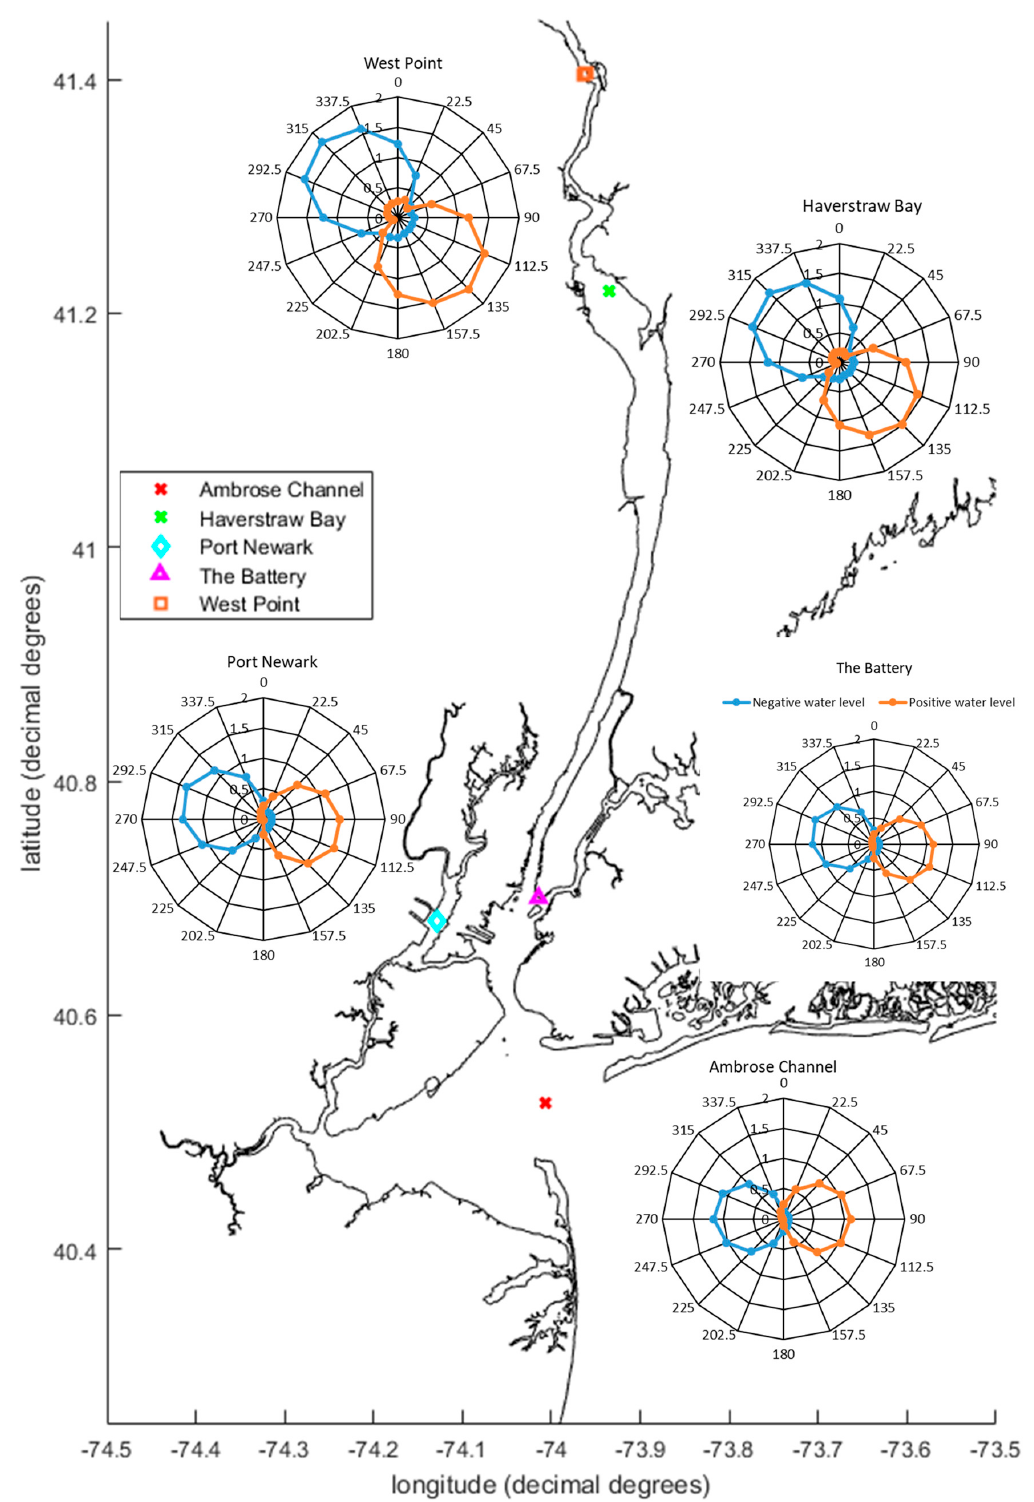
Figure 8. Maximum surges (orange) and minimum negative surges (blue) from separate stress-test simulations with 16 directions of wind. Radial axes are water level in m. Temporal minima and maxima from datasets like those in Figure 7 are plotted for all 16 wind directions at the five